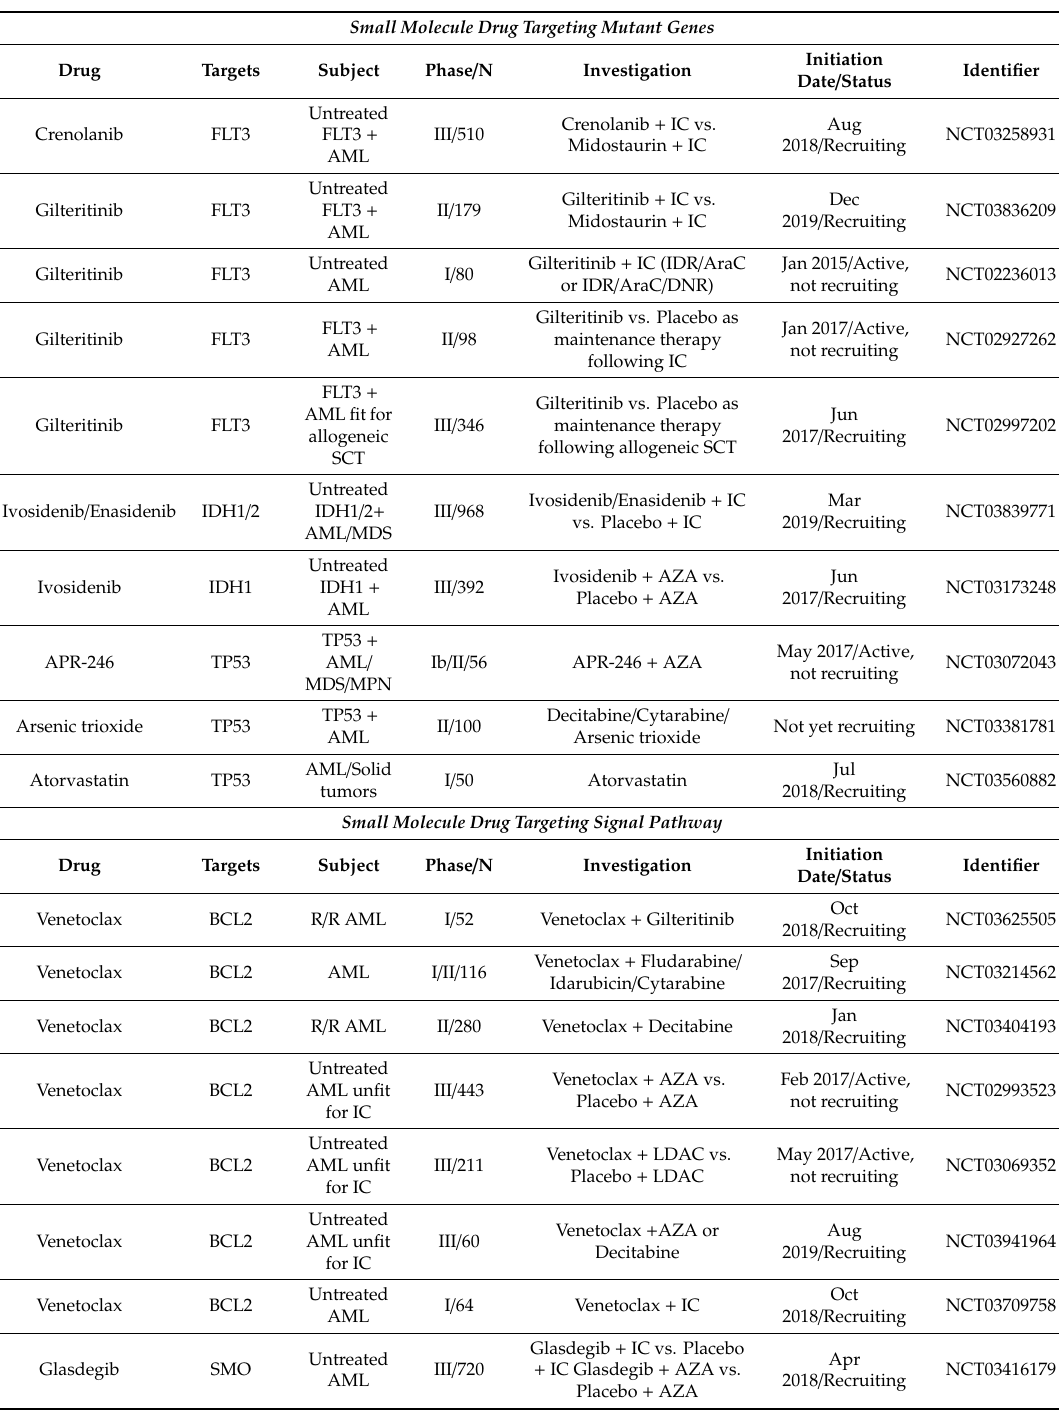
Table 2. Selected ongoing trials for AML featuring the targeted